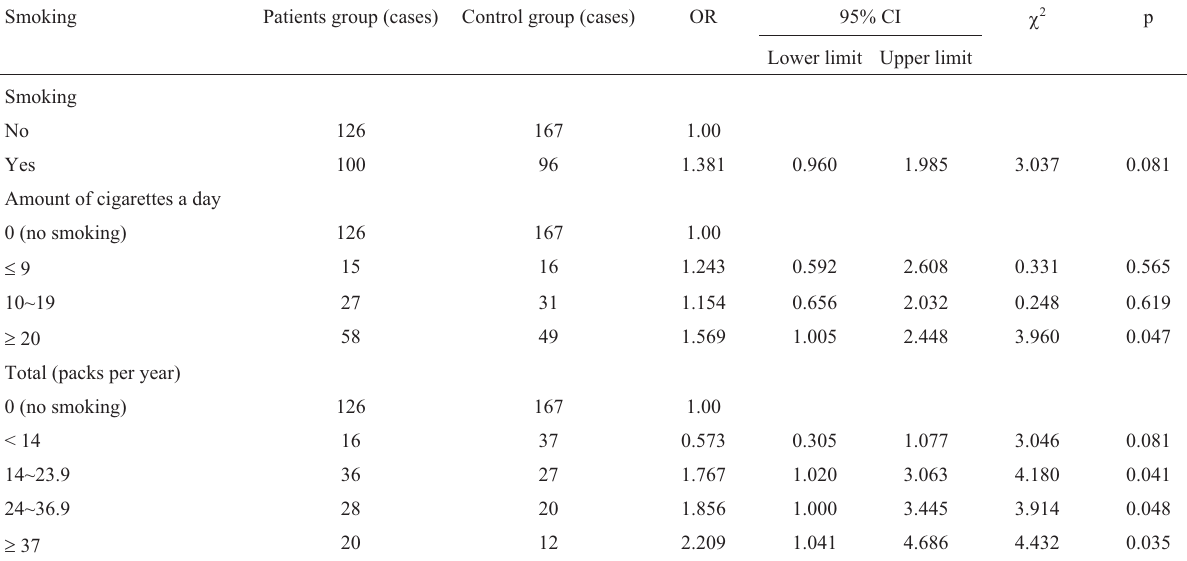
Table 3 - Relationship between smoking and pancreatic